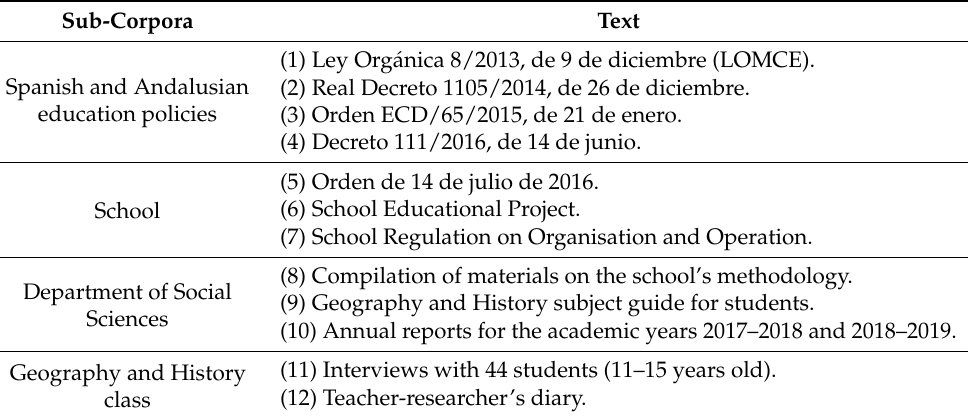
Table 1. Composition and organisation of the research corpus.